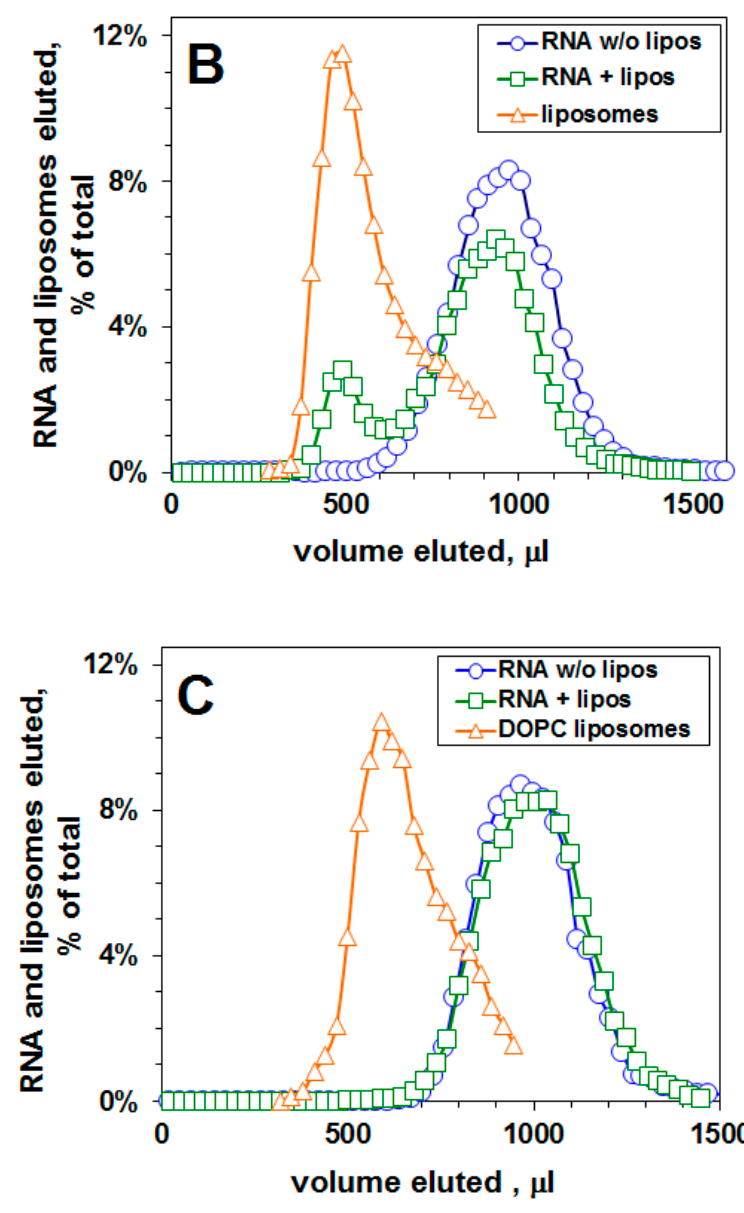
Figure 2. Selection of RNA aptamers specific to lipid rafts within liposomal membrane (raft-aptamers). RNA 70N/50N (100 pmol) binding to DOPC liposomes or rafted liposomes (DOPC/SM/CHOL) (0.6/0.3/0.1) in buffer 50mM KCl/HEPES, 5 mM MgCl 2 , 2 mM CaCl 2 , pH 7. ( A )— progress of selection: percent of RNA bound to liposomes vs. cycle number. ( B )—elution profiles of RNA and rafted liposomes after 7th cycle. ( C )—elution profiles of RNA and DOPC liposomes after 7th cycle. The circles—elution profile of RNA without liposomes; the squares—the elution profile of RNA in the presence of liposomes; the triangles—the elution profile of liposomes (as OD 400 ). RNA concentration 0.5 μ M, liposome concentration 10 mg/mL.